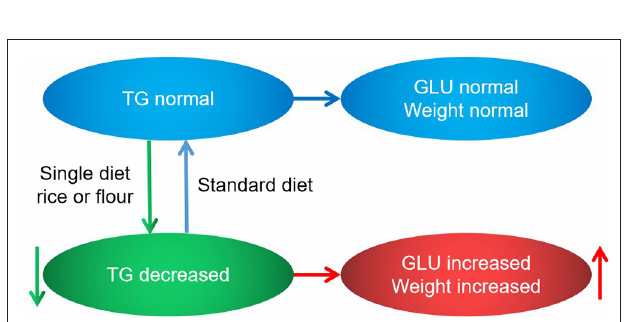
FIGURE 10 | Diagram of the mechanism showing how diet types affect body weight and blood glucose levels. Blue ellipses and lines are presented as normal states, green ellipses and lines are presented as normal states, and red ellipses and lines are presented as normal